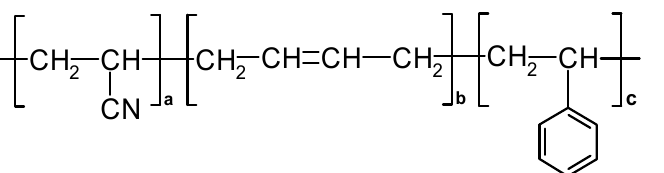
Figure 1. Chemical structure of acrylonitrile/butadiene/styrene a—polyacrylonitrile; b—polybutadiene; c—polystyrene [17].